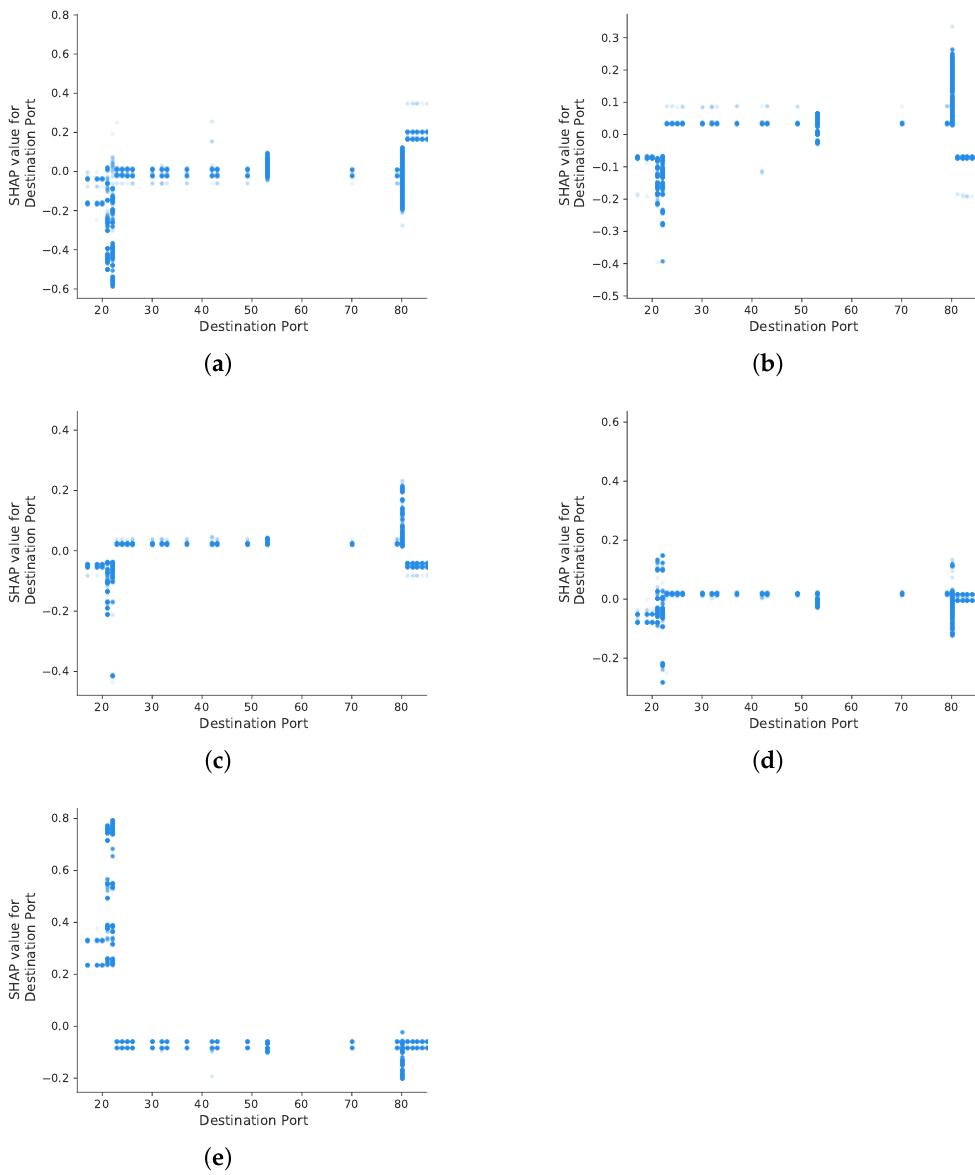
Figure 5. Dependence plots. ( a ) Benign; ( b ) DoS; ( c ) DDoS; ( d ) Port scan; ( e ) Brute